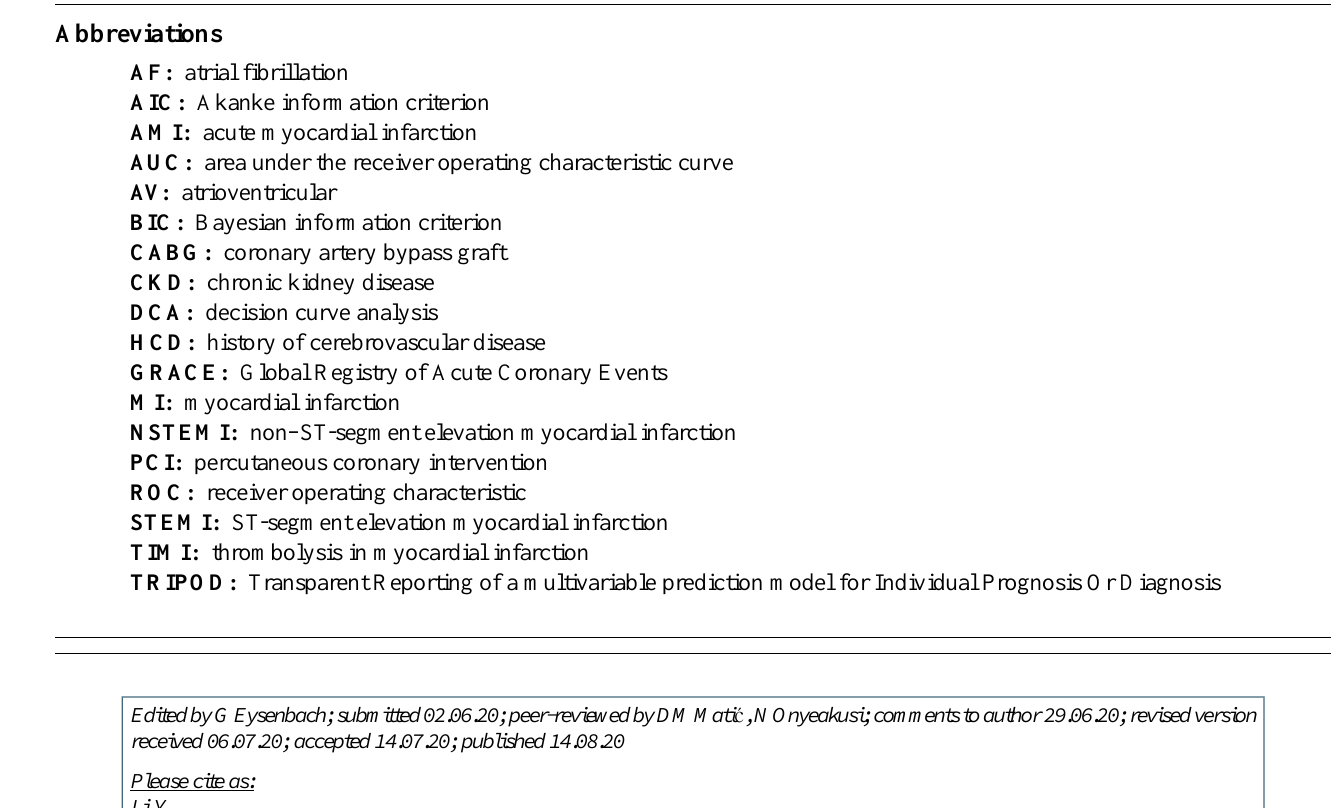
Diagnostic Model for In-Hospital Bleeding in Patients with Acute ST-Segment Elevation Myocardial Infarction: Algorithm Development and